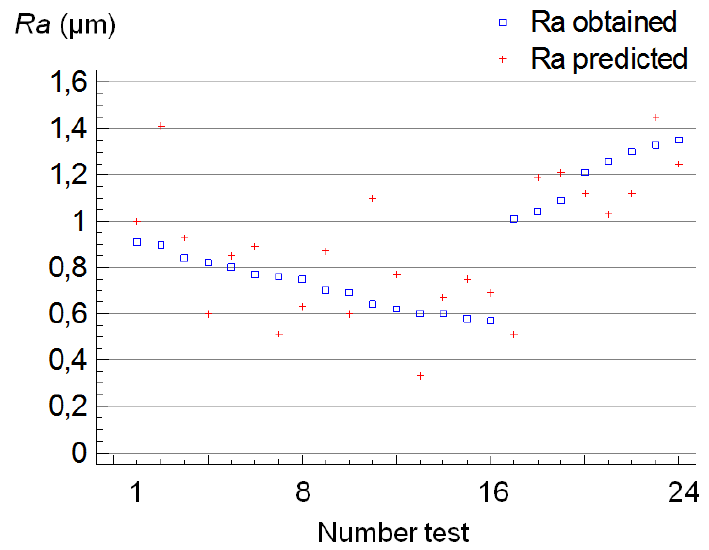
Figure 9. Plot with the values of Ra for the validation of the